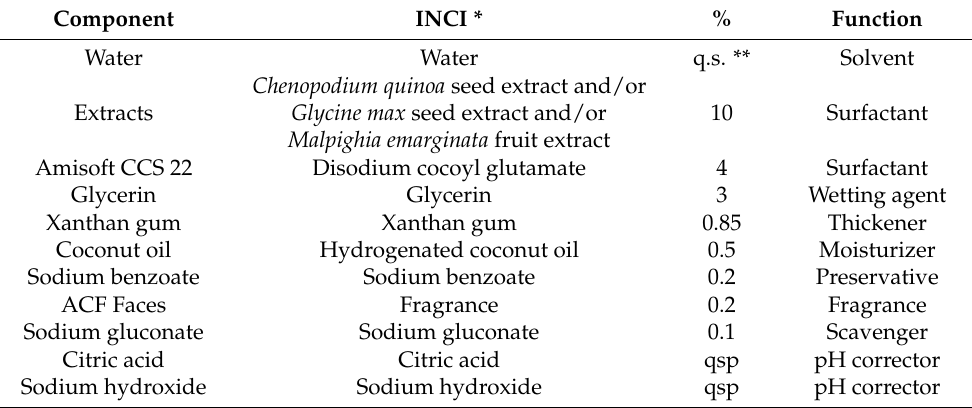
Table 6. Shampoo formulations developed using criteria established in the present study.